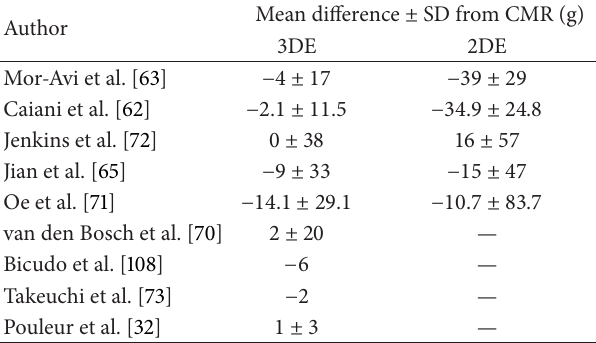
Figure 12: The full-volume of the left ventricle can be divided into 16 or 17 regional pyramidal subvolumes whose base is on the endocardium (different colours identify different segments) and the apex is in the center of gravity within the cavity of the left ventricle. The volume changes of individual regional pyramidal subvolume can be tracked throughout the cardiac cycle (see the time-volume curves in the lower part of the figure) and a “regional ejection fraction” can be measured. Table 3: Differences between left ventricular mass calculation by three-dimensional echocardiography and conventional two- dimensional echocardiography in comparison with cardiac mag- netic